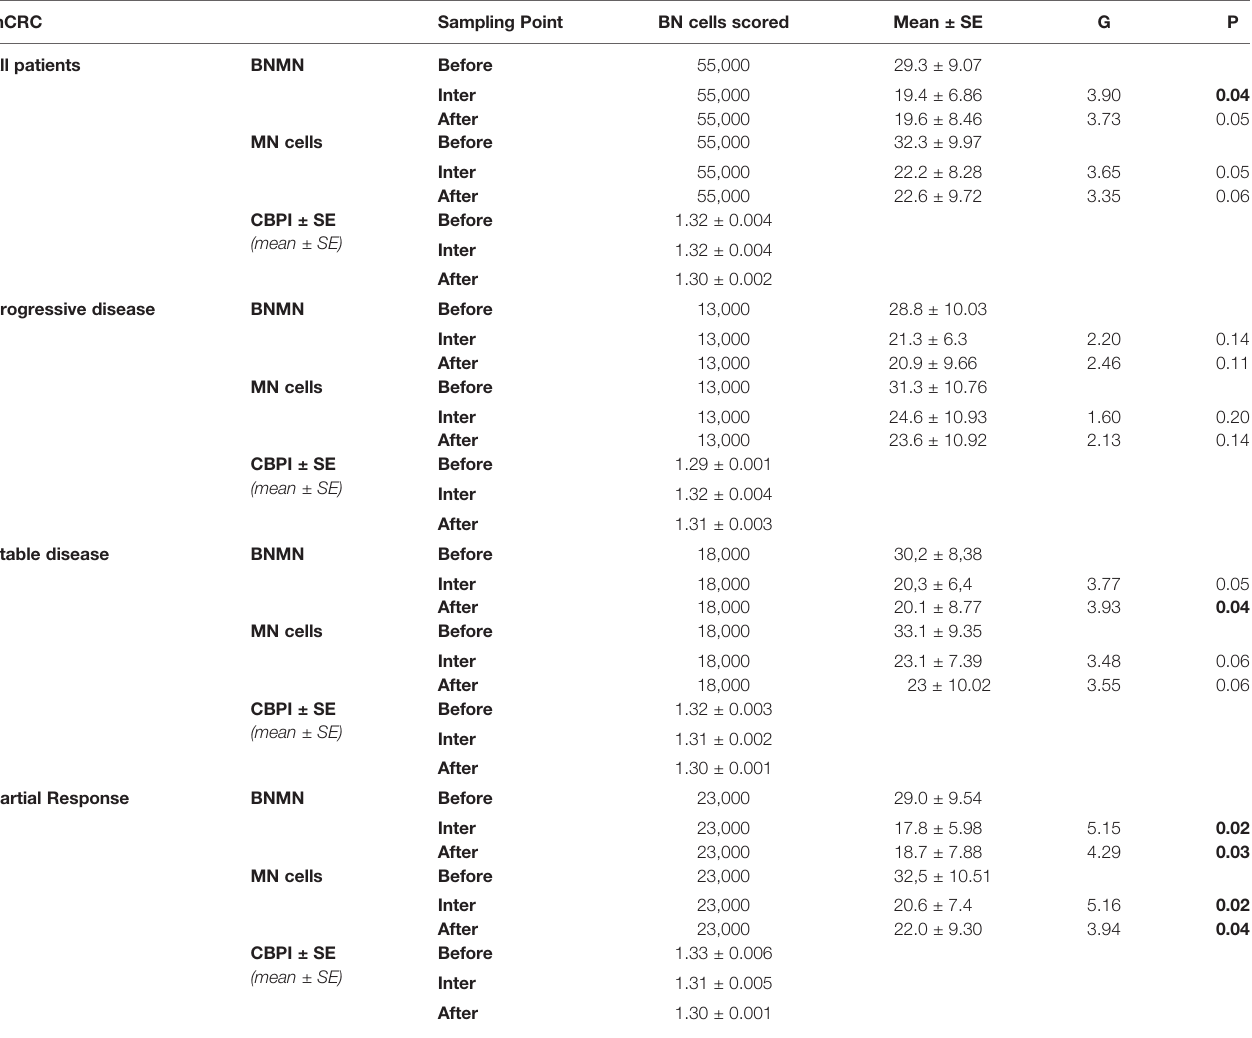
TABLE 3 | Statistical analysis of the mean BNMN and MNf of mCRC patients at the beginning (before), the middle (inter) and at the end (after) of the treatment for all mCRC patients and according to their disease response (progressive disease, stable disease, partial response, and complete response). mCRC Sampling Point BN cells scored All patients